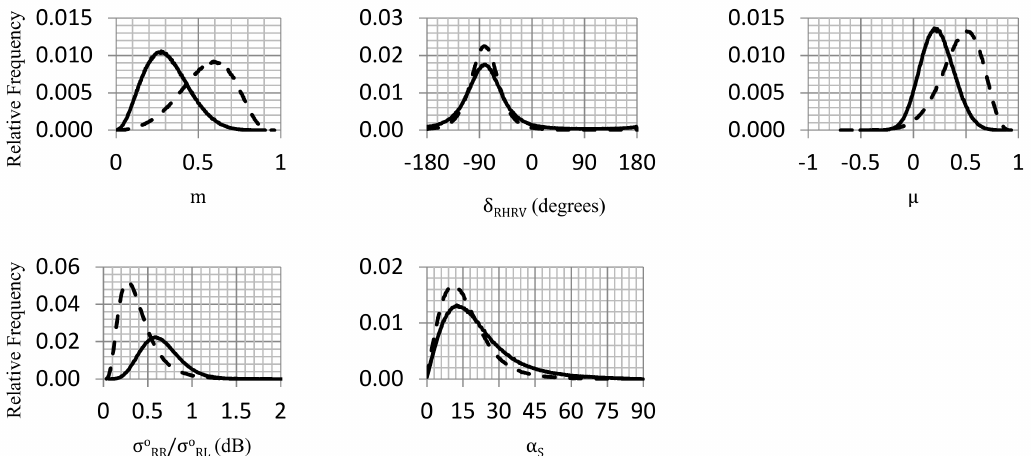
Figure 3. Histograms of CP parameters for the case of RCM HR SAR mode. Solid line refers to FYI and dashed line refers to MYI. Vertical red lines in σ 0